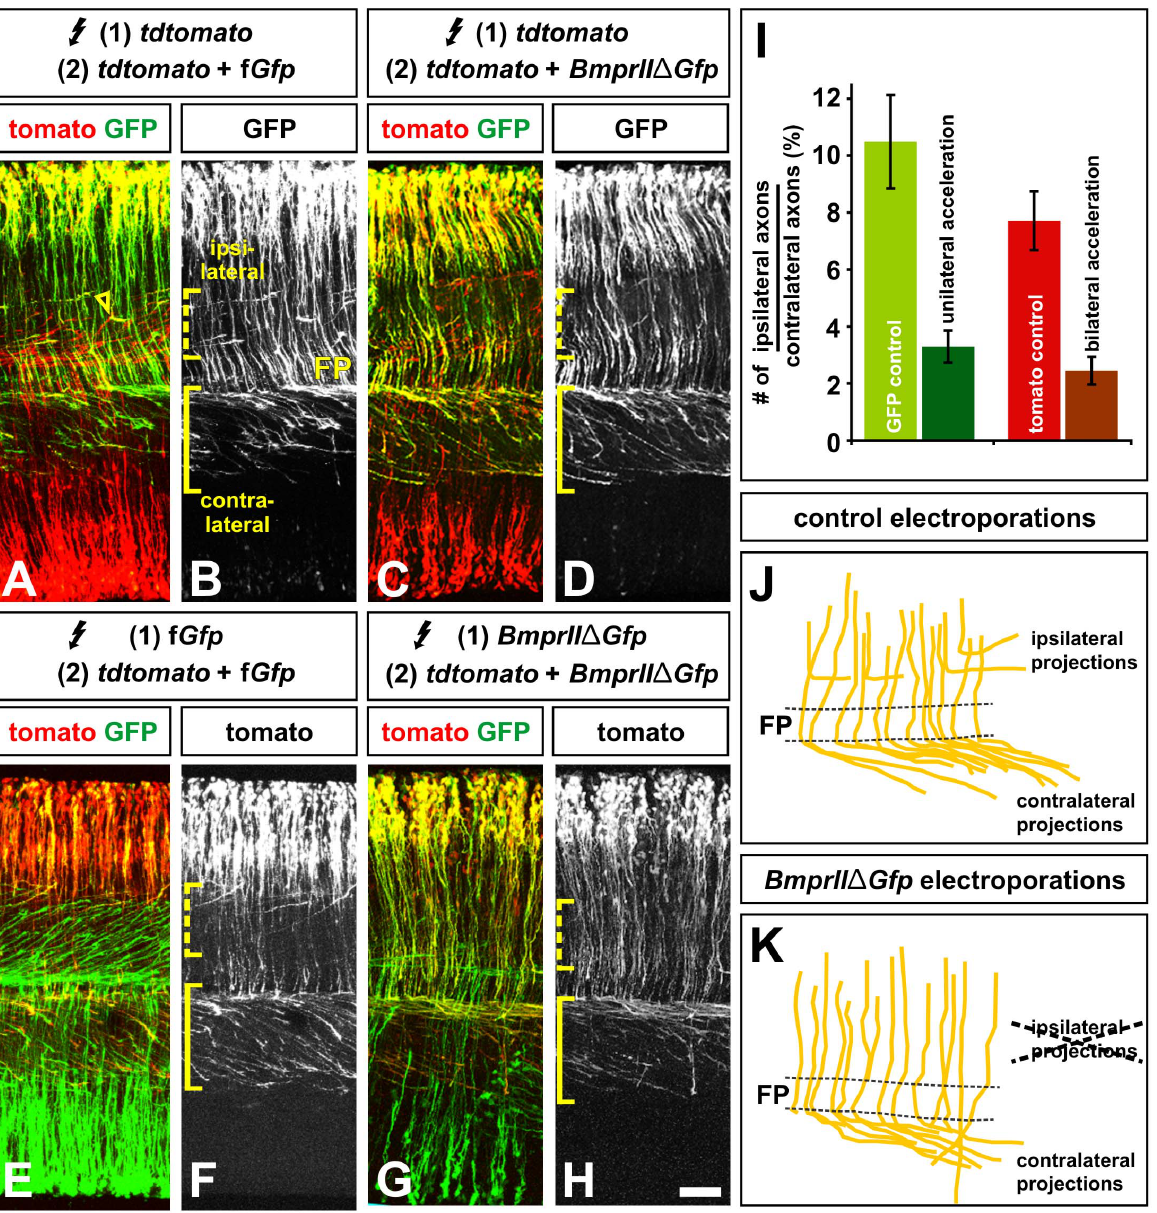
Figure 2. Accelerating axon growth either unilaterally or bilaterally results in the same turning errors. (A–I) To compare the consequence of either unilaterally or bilaterally accelerating commissural axon growth, chicken embryos were electroporated at HH stages 14/15 and longitudinal open book preparations of the spinal cord generated at HH stages 23/24. All expression vectors were electroporated under the control of the Math1 enhancer. Only the behavior of the yellow GFP + tomato + commissural axons was monitored (A–H) and quantified (I). (A, B, E, F, J) By HH stages 23/24, control neurons electroporated with both fGFP and tomato (yellow), in either a control tomato background (A, B) or a control GFP background (E, F) project axons ventrally and then sharply rostrally, to extend towards the brain. There are two classes of yellow axons, an ipsilateral population that turns before the FP (dotted bracket, B, F) and a contralateral commissural population that turns after crossing the FP (solid bracket, B, F). Note that the ipsilateral axons often turn on apparently encountering a contralateral dI1 axon (arrow, A). (C, D, K) In contrast, by the same stage, commissural neurons unilaterally electroporated with BMPRII D Lim-GFP in a control tomato + background, project very few axons ipsilaterally (dotted bracket, C) and the contralaterally projecting commissural axons turn both rostrally and caudally (solid bracket, C). (G, H, K) Commissural neurons electroporated with tomato in a bilaterally accelerated BMPRII D Lim-GFP + background make very similar turning errors to those observed after unilateral acceleration (C, D). (I) Control commissural axons (either GFP + in a tomato + background or tomato + in a GFP + background) project ipsilaterally to a statistically similar extent (p . 0.078, Student’s t -test; GFP + axons: 10.5% 6 1.3 turn ipsilaterally, n=3698 total axons in 18 open book preparations; tomato + axons: 7.7% 6 1.0, n=1557 axons in 11 open book preparations). In contrast, far fewer axons turned ipsilaterally after either unilateral or bilateral acceleration of commissural axons (unilateral acceleration: 3.3% 6 0.55, n=1321 axons in 6 open book preparations, p , 0.003 statistically similar to control GFP + axons; bilateral acceleration: 2.4% 6 0.49 n=1108 axons from 6 open book preparations, p , 0.01 statistically similar to control tomato + axons). There is no statistical difference between the phenotype observed after unilateral or bilateral acceleration of commissural axons (p . 0.13). Scale bar: 60 m m.